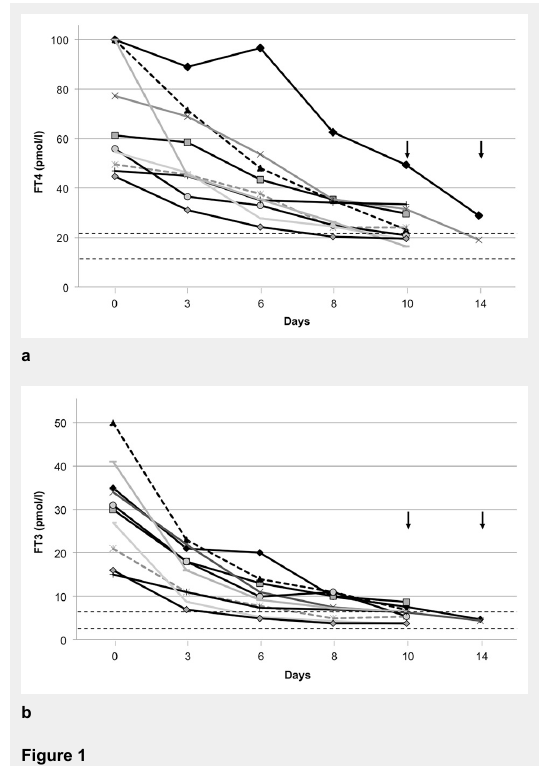
Serum concentrations of fT4 (1a) and fT3 (1b) in patients (n = 10) with Graves’ disease before and during treatment with a rapid preoperative hormone blocking protocol. Horizontal dashed lines indicate reference ranges, and the arrows denote time of surgery on day 10 (n = 8) and day 14 (n =